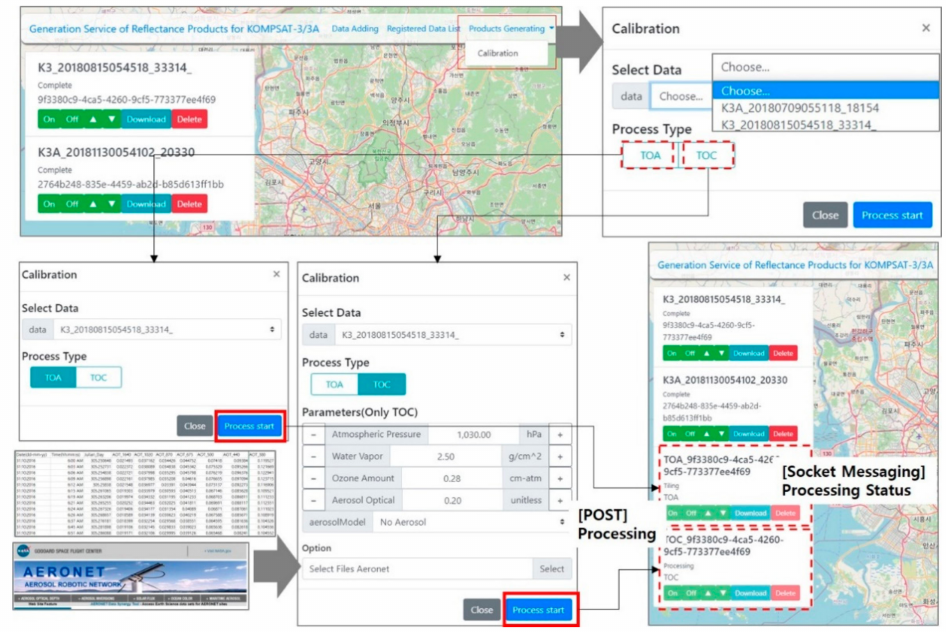
Figure 7. Generation processes of TOA and TOC reflectance products in the SaaS: entering atmo- spheric variables and listing